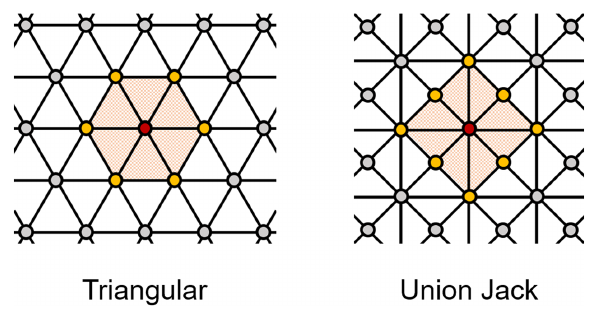
FIG. 1. Two-dimensional triangulated lattices. The shaded area represents a unit cell, based on which we decompose the underlying Boolean functions of the systems and derive bounds on their nonquadracity (details in Appendix